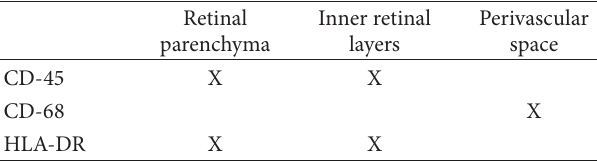
Table 2: Distribution of microglia in healthy eyes